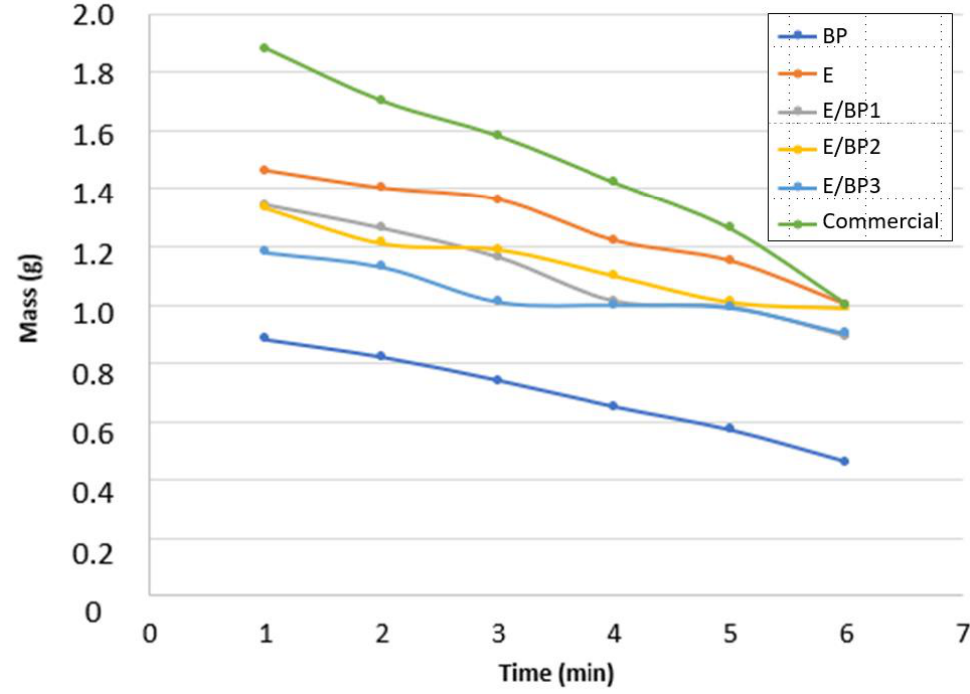
Fig. 7. The change of mass of fabricated brake pad during friction test Table 6. Mass loss rate, wear rate, and friction coefficient of specimens with different